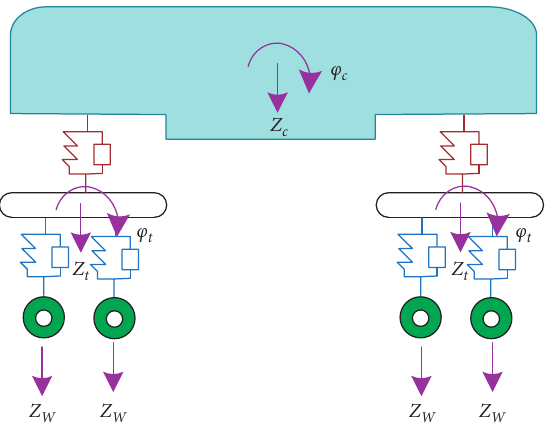
Figure 4: The vehicle